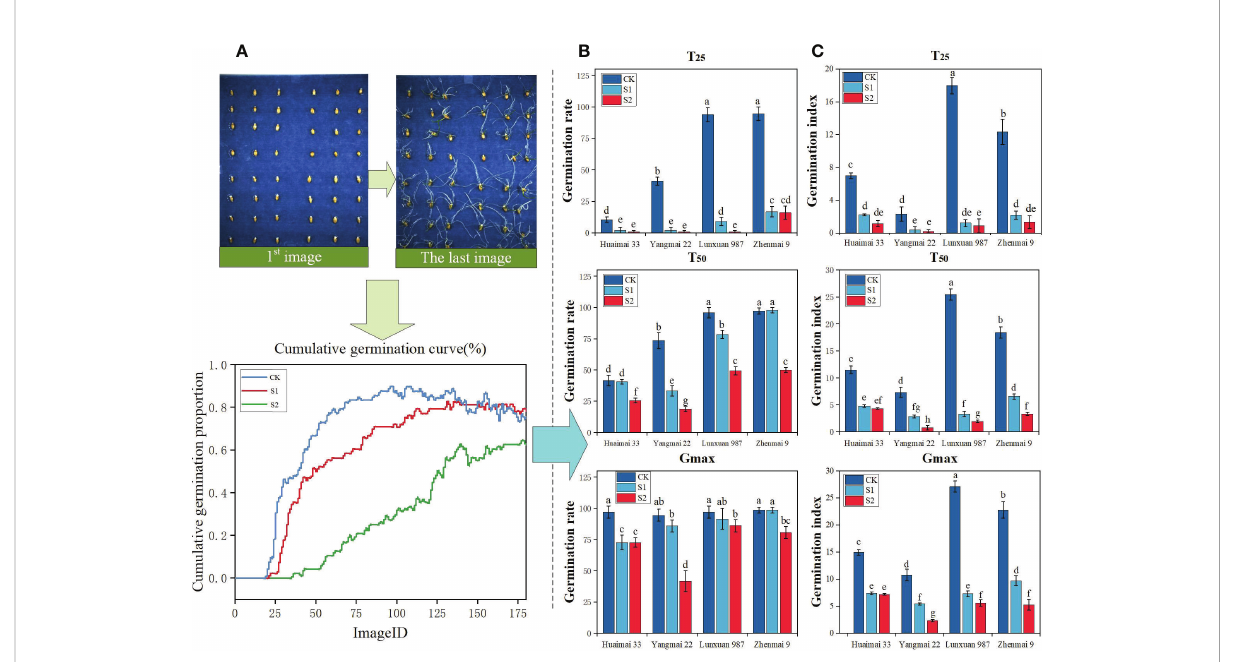
FIGURE 8 Results of germination vigour analysis of wheat seeds under different salt stresses. (A) A series of images and cumulative germination curves of the germination test process of wheat seeds under three groups of salt stress treatments (B) Quantitative germination rates, including the germination rates of wheat seeds of four genotypes at T25, T50 and Gmax stages under three groups of salt stress (C) Quantitative germination indices, including the germination indices of wheat seeds of four genotypes at T25, T50 and Gmax stages under three groups of salt stress. According to ANOVA and LSD, different letters indicate signi fi cant differences in speci fi c sequences, P < 0.05.